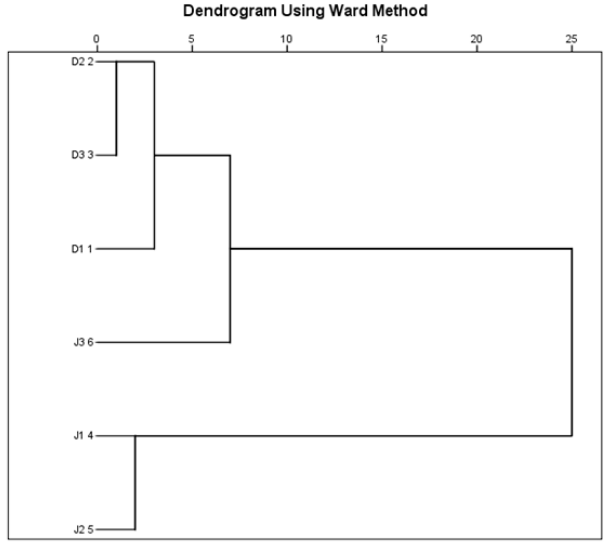
Figure 8. Cluster dendrogram showing the grouping of sampling sites based on RI, TSI, and concentrations of SO 42 − , Cl − , NH 4+ -N, and NO 3 − -N.